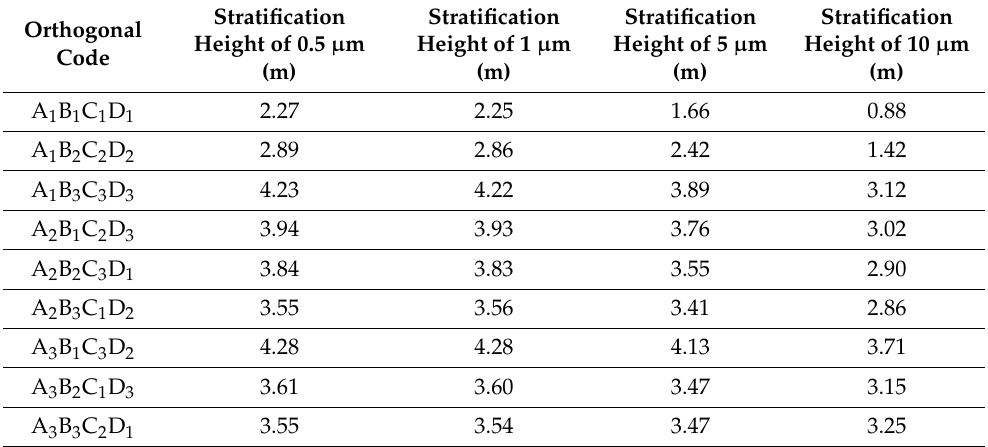
Table 5. Workspace inhomogeneity factor for each particle size at various orthogonal experimental codes. 0.5 µ m Orthogonal Inhomogeneity Code Factor of Factor of Workspace Workspace